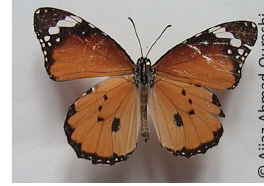
Image 16. Danaus chrysippus